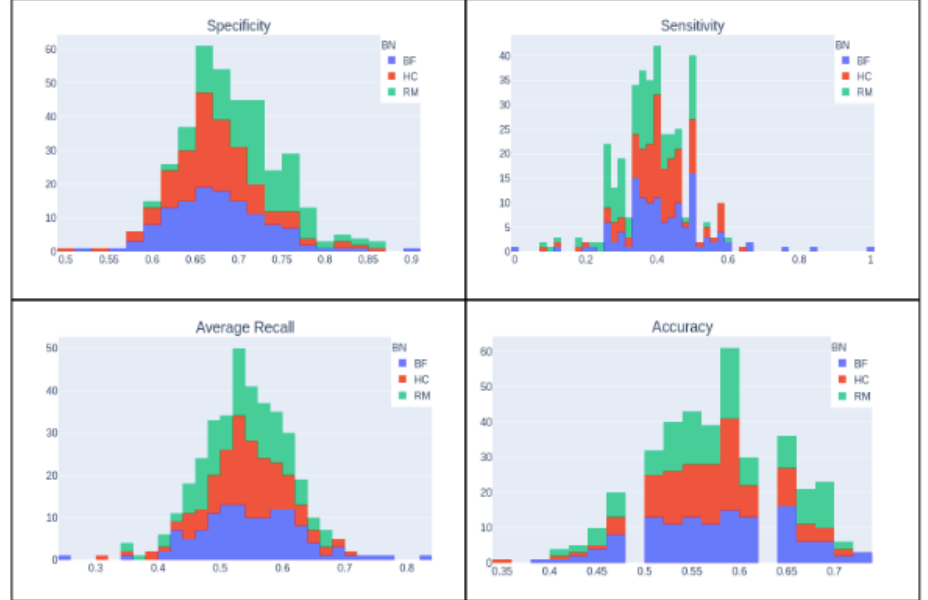
Figure 6. Bayes network (HC, BF, and RM) performance metric histograms (specificity on the top left, sensitivity on the top right, average recall on the bottom left, and accuracy on the bottom right) over the resulting collection of the Granger experiments performed on the multivariate time-series data set. The average of each performance metric for each Bayes network is reported in Table 6.